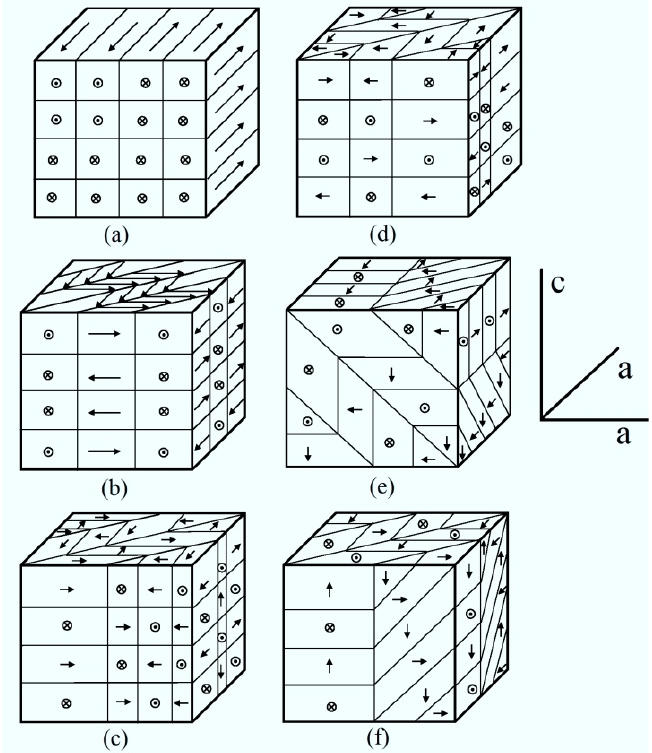
Figure 4. The compatible domain patterns in tetragonal phase state: ( a ) parallel and antiparallel 180° domain patterns; ( b ) two kinds of 90° and 180° mixed domain patterns; ( c )–( f ) four kinds of 90° domain patterns.